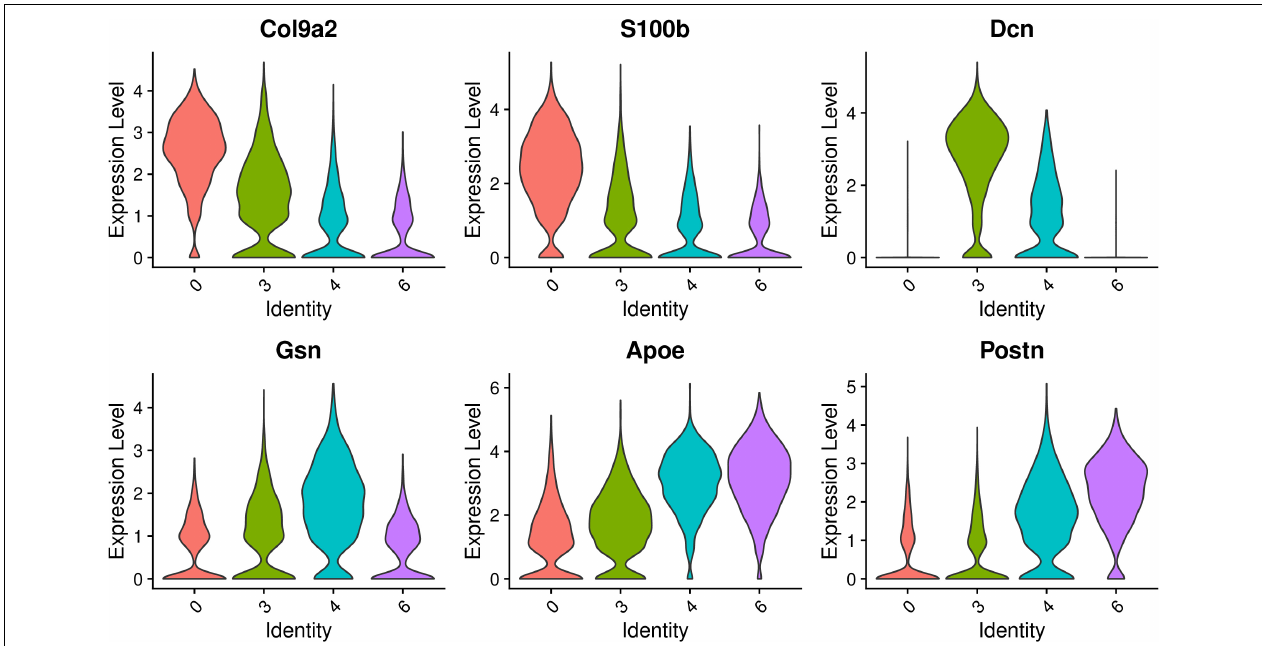
FIGURE 9 | Expression of select genes of these four GER cell clusters. Violin plots showing normalized log-transformed expression values for the select genes for cluster 0, cluster 3, cluster 4, cluster